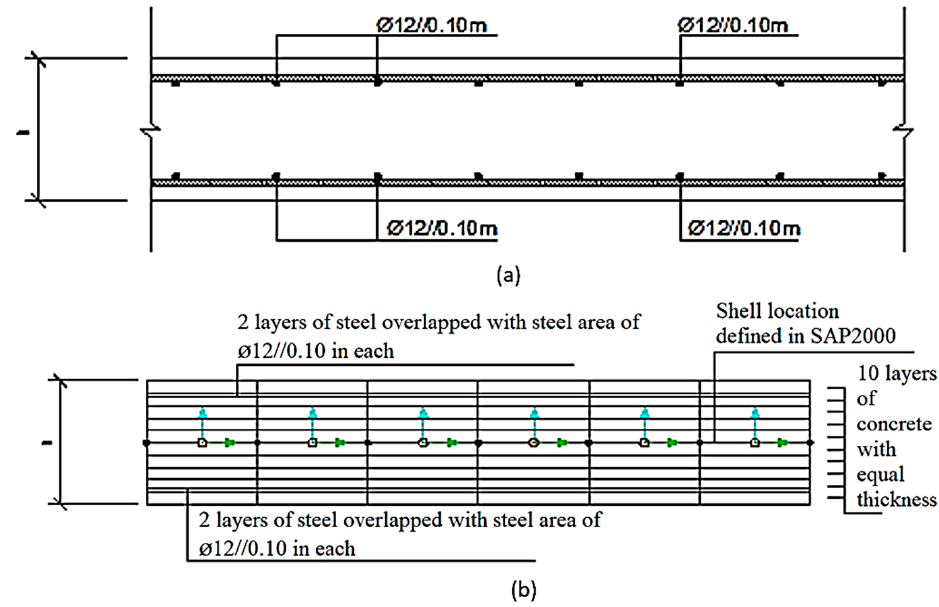
Figure 11. Cross-section for ( a ) Reinforced concrete slab and ( b ) non-linear Shell element.